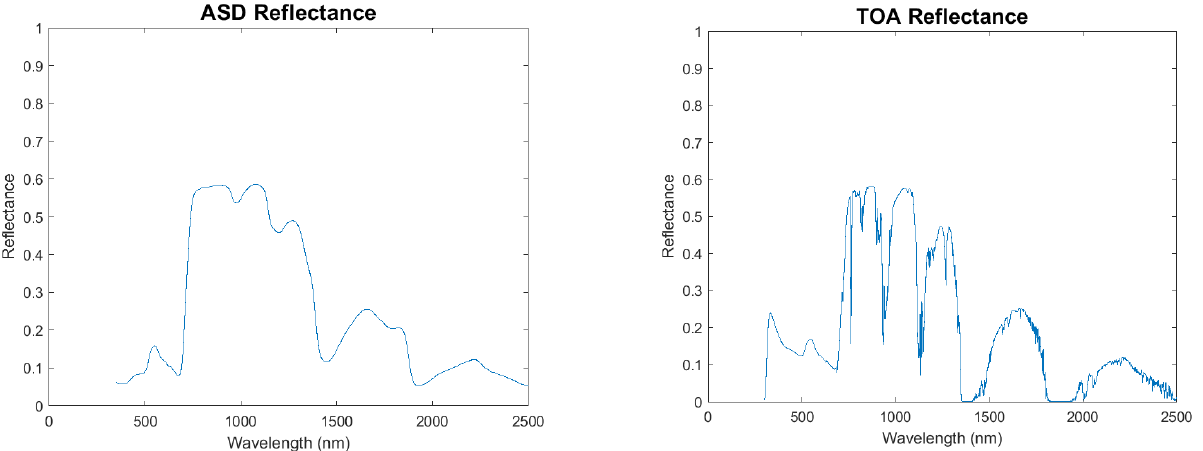
Figure 9. Surface level reflectance of a white fir tree vs. MODTRAN-simulated TOA reflectance. Note the water absorption in the longer wavelengths and the scattering due to aerosols in the shorter wavelengths.